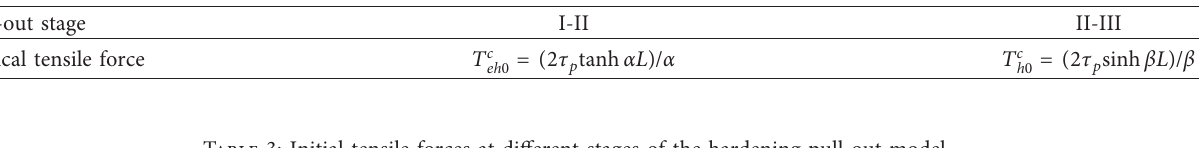
Table 2: Critical tensile force between the two stages of the hardening pull-out model.